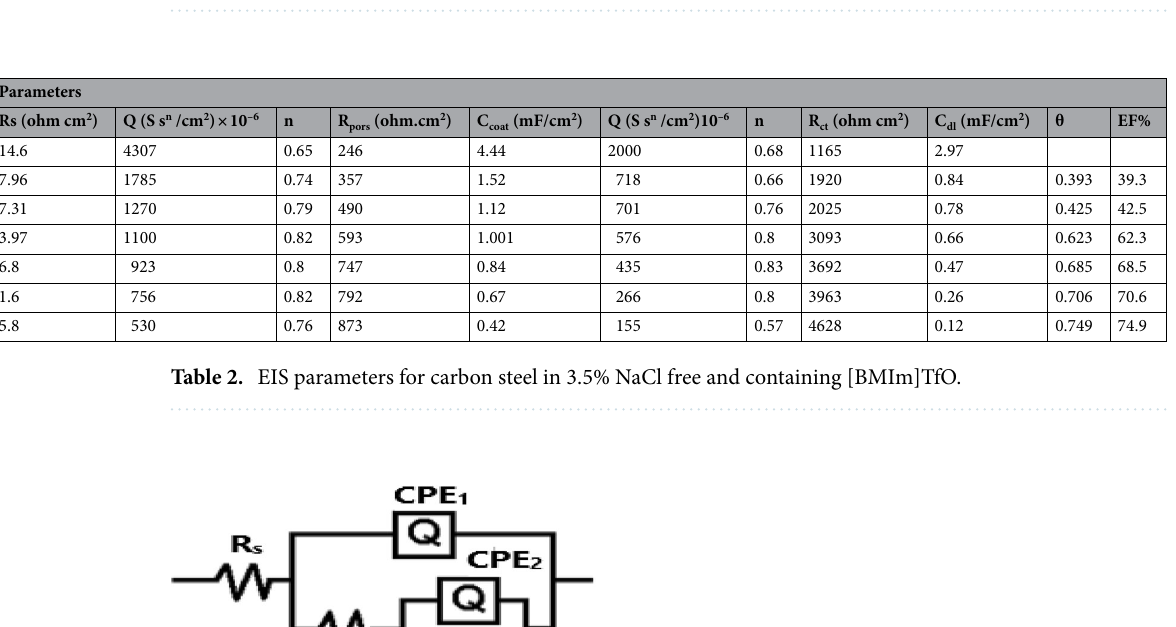
Figure 3. Typical Nyquist plots for the carbon steel in 3.5% NaCl without and with different concentrations of [BMIm]TfO.